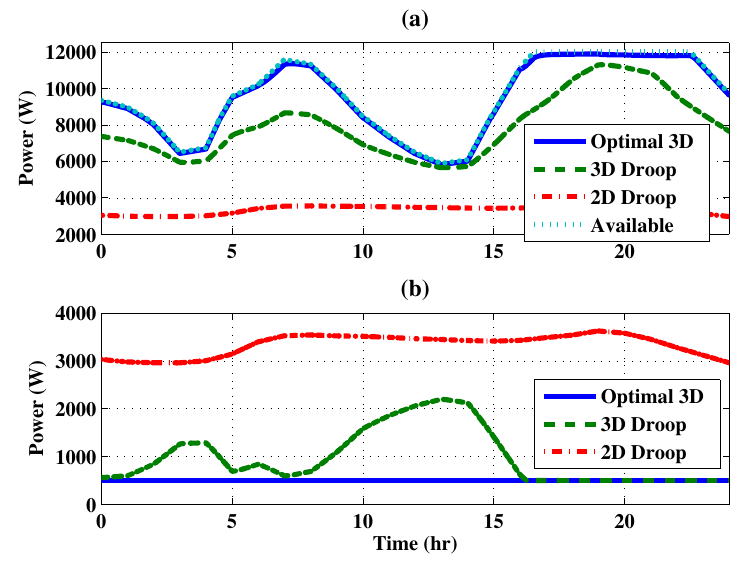
Figure 22. Power supplied from ( a ) wind source and ( b ) conventional source using 2D, 3D and optimal 3D droop. Power available from the wind is also shown.